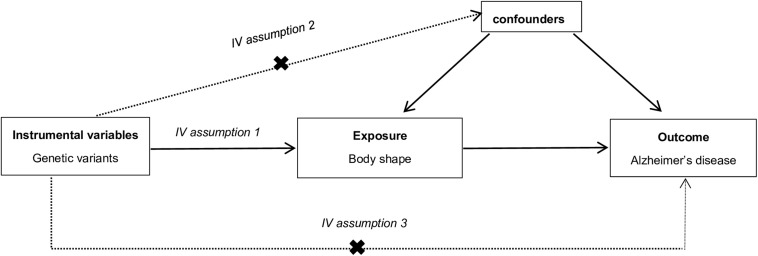
The explanation of Mendelian randomization analysis by a directed acyclic graph. The accuracy of estimating causality using Mendelian randomization (MR) analyses is based on the following three assumptions: (1) The instrumental variable (IV) associate robustly with the exposure (IV assumption 1). This assumption can be satisfied by ensuring F statistic > 10 and that SNPs are selected using genome-wide significance levels (P < 5 × 10–8), which suggests that potential bias from weak IV should not be substantial (Nordestgaard et al., 2017). (2) The IV is independent of combined influence of all confounders (IV assumption 2). For the same population and reference, we assess correlation of linkage disequilibrium between SNPs associated robustly with exposure and SNPs linked to possible known confounders. If the correlation coefficient is higher (i.e., r2 ≥ 0.5), the corresponding selected SNPs will be discarded (Geng et al., 2018). (3) The IV is independent of the outcome given the exposure and confounders (IV assumption 3). Horizontal pleiotropy, that IVs influence the outcome through alternative pathways other than the exposure, could violate this assumption. It can be checked by using MR-Egger regression and MR-PRESSO method (Noyce et al., 2017; Verbanck et al., 2018).